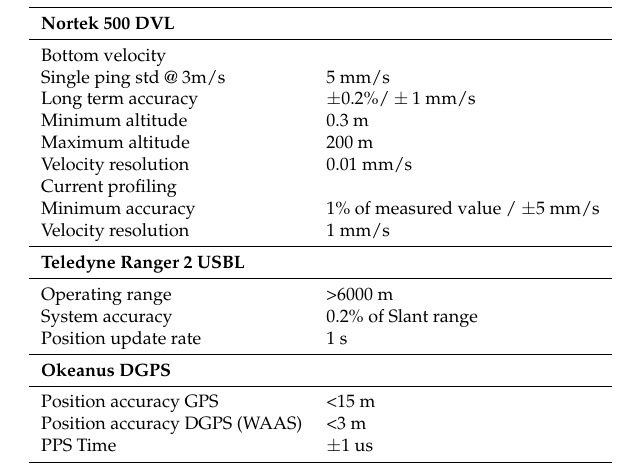
Table 1. The DVL, USBL, and GPS system technical specification.